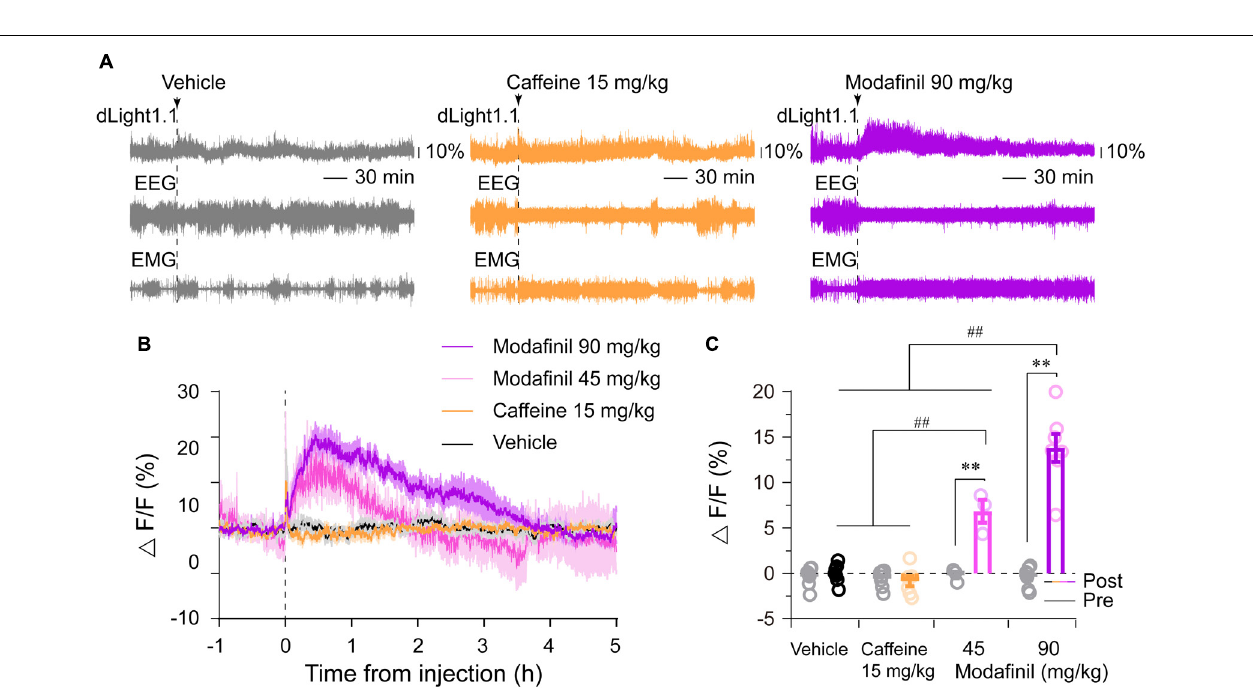
Frontiers in Neuroscience |